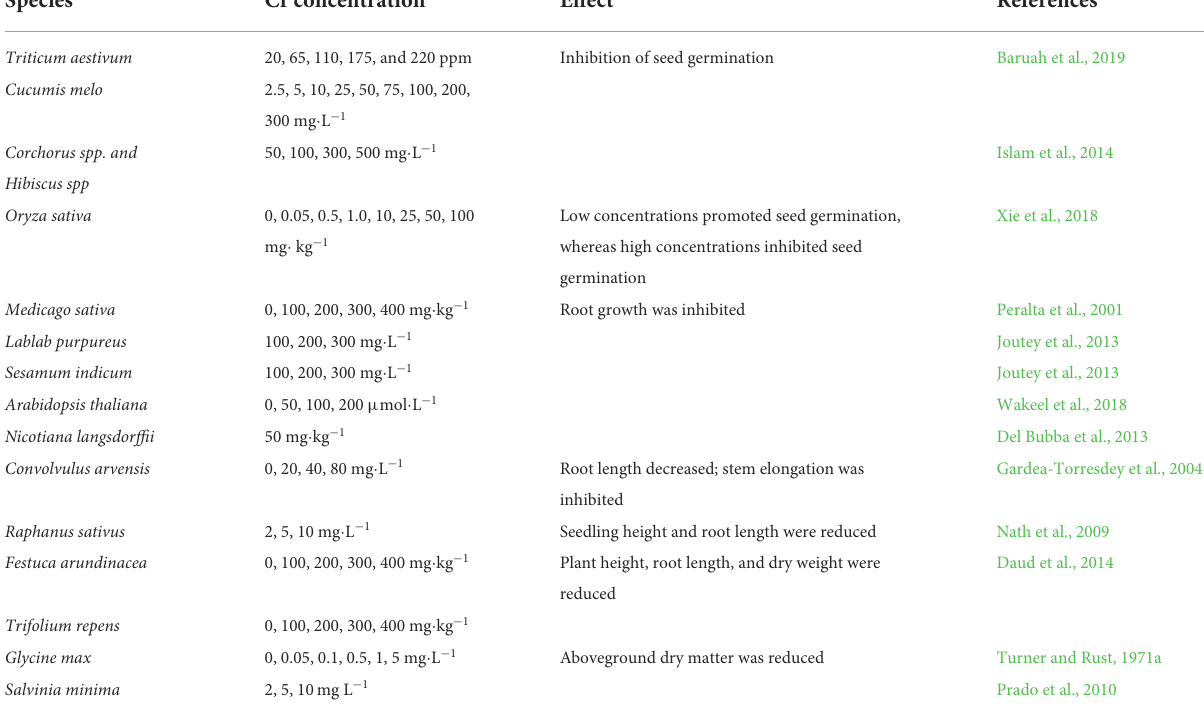
TABLE 1 Overview of the effect of chromium on plant growth and